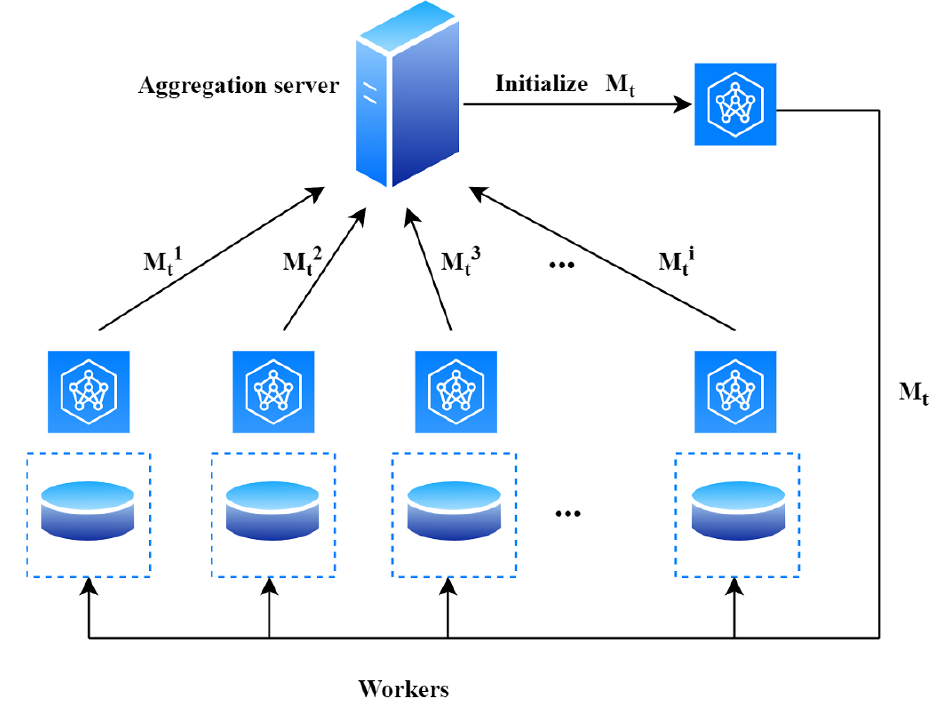
Figure 1. The general operations of the Federated Learning